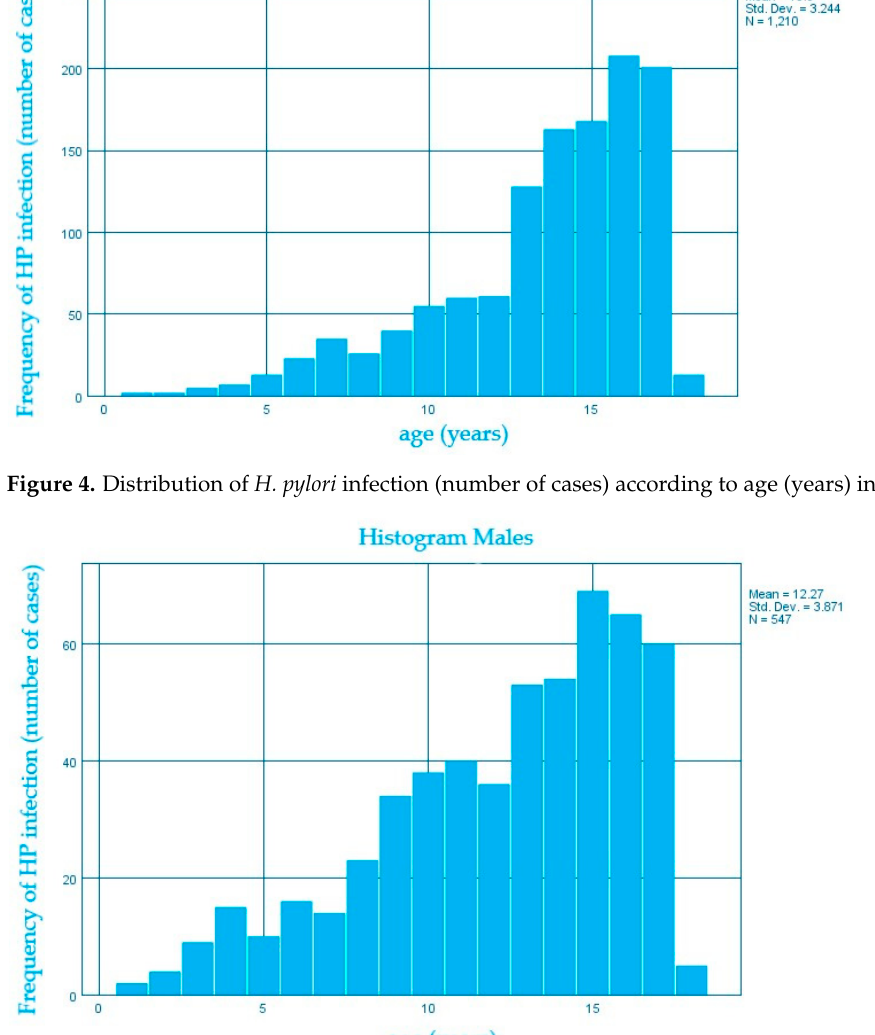
Figure 6. The distribution of age (years) within gender variables in H. pylori infection. According to patients’ backgrounds, out of the total number of 1757 patients, we ob- served that 1114 of them (63.4%) originated from the rural areas, whereas 643 of them originated from urban areas with a percentage of 36.6%. (Table 3). From the statistical analysis, it was concluded that there was a powerfully significant difference of this asso- ciation ( χ 2; p < 0.0001) (Table 3). The presence of gastritis with H. pylori in patients from rural environments is 2.2 times higher than in patients from urban environments (OR = 2.2).